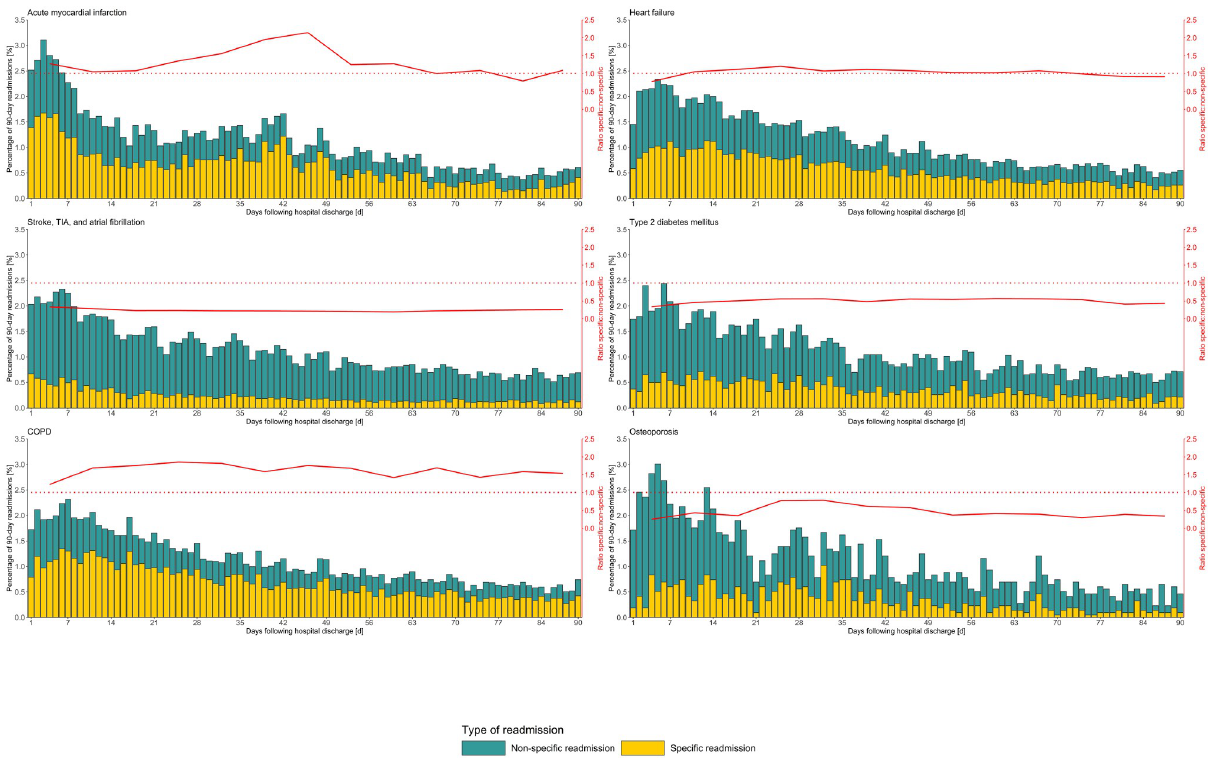
Fig 3. Distributions of all-cause, specific, and non-specific readmissions for six different common diseases. The frequencies of all-cause readmissions are shown by the green bars’ height. Frequencies of specific readmissions are shown in yellow. Ratios between specific and non-specific readmissions are indicated as red solid lines referring to the y-axis on the right side, which shows aggregated weekly values. Ratios > 1 (above dotted red line) indicate a higher number of specific than non-specific readmissions.